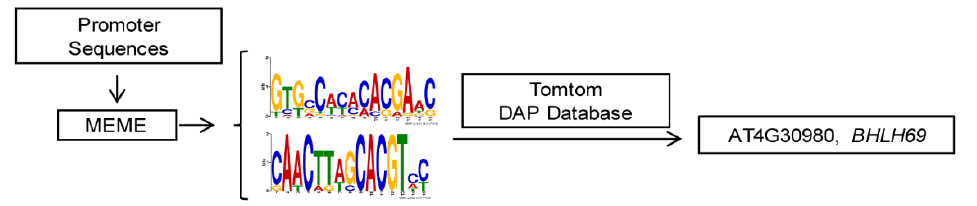
Figure 6. Diagram of the techniques used for promoter motif and transcription factor binding